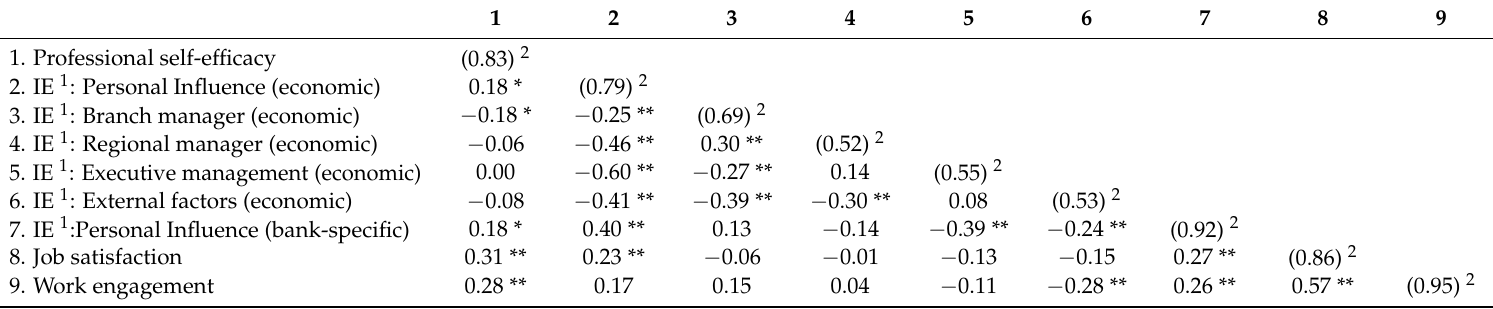
Table 2. Correlations and reliability coefficients for professional self-efficacy, IE 1 (economic and bank-specific), job satisfaction, and work engagement (N = 136).